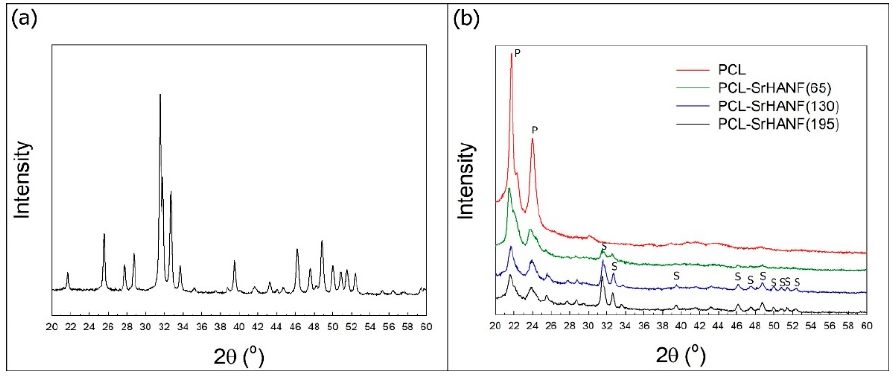
Figure 2. XRD patterns of the ( a ) SrHANFs and ( b ) PCL–SrHANF membranes. P: PCL, S: SrHA.